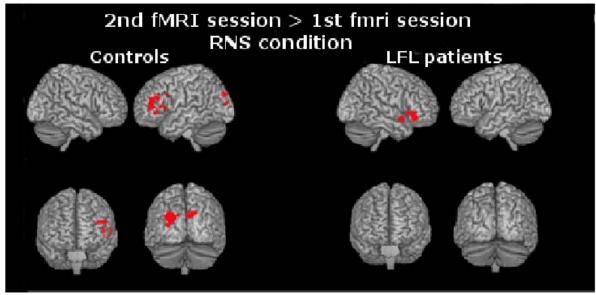
Figure 3. Increased activation in the 2ndfMRI session for the RNS condition. In healthy adult controls, changes were seen in the left prefrontal cortex, including the inferior and middle frontal gyri, intraparietal sulcus, cuneus and precuneus. In patients with LFL, statistical significant changes were seen in the contralesional hemi- sphere, mainly in the right inferior frontal gyrus, extending to the superior temporal gyrus and insula.